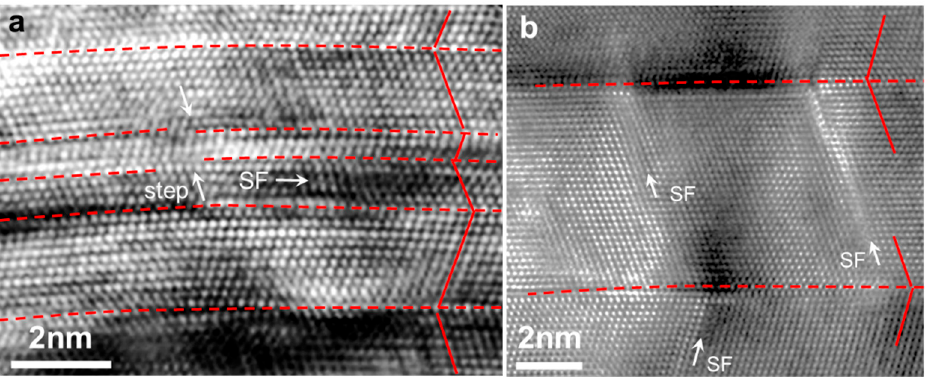
Figure 4. ( a ) Partial dislocations on the TBs leading to the formation of several steps (marked by arrows) on the TBs for twins with thicknesses of 0.6–2.4 nm. ( b ) Partial dislocations resulting in SFs intersect with the TBs in thicker twins (marked with SF).